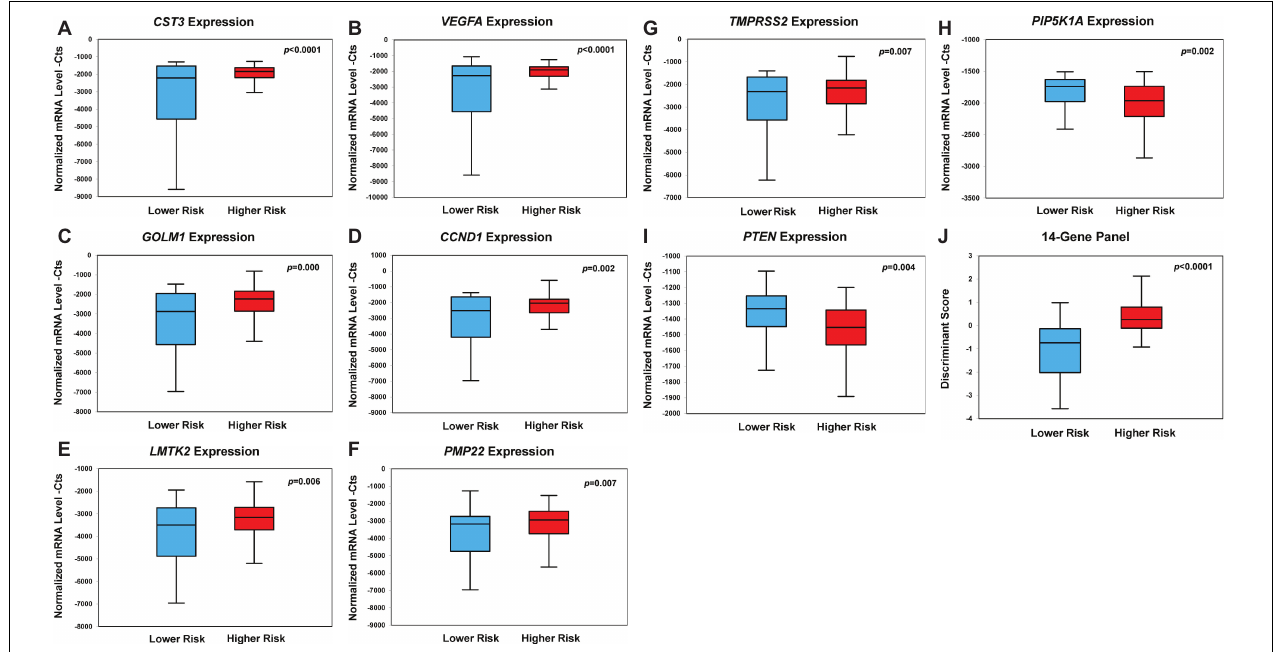
FIGURE 2 | Box plots of genes with statistically significant differential gene expression in the prospective PCa urine cohort ( n = 202). Box plot of expression of CST3 (A) , VEGFA (B) , GOLM1 (C) , CCND1 (D) , LMTK2 (E) , PMP22 (F) , TMPRSS2 (G) , PIP5K1A (H) , PTEN (I) , and the 14-Gene Panel (J) . Normalized mRNA level—Cts is defined as cycle threshold (Ct) (sample)/Ct (actin) *